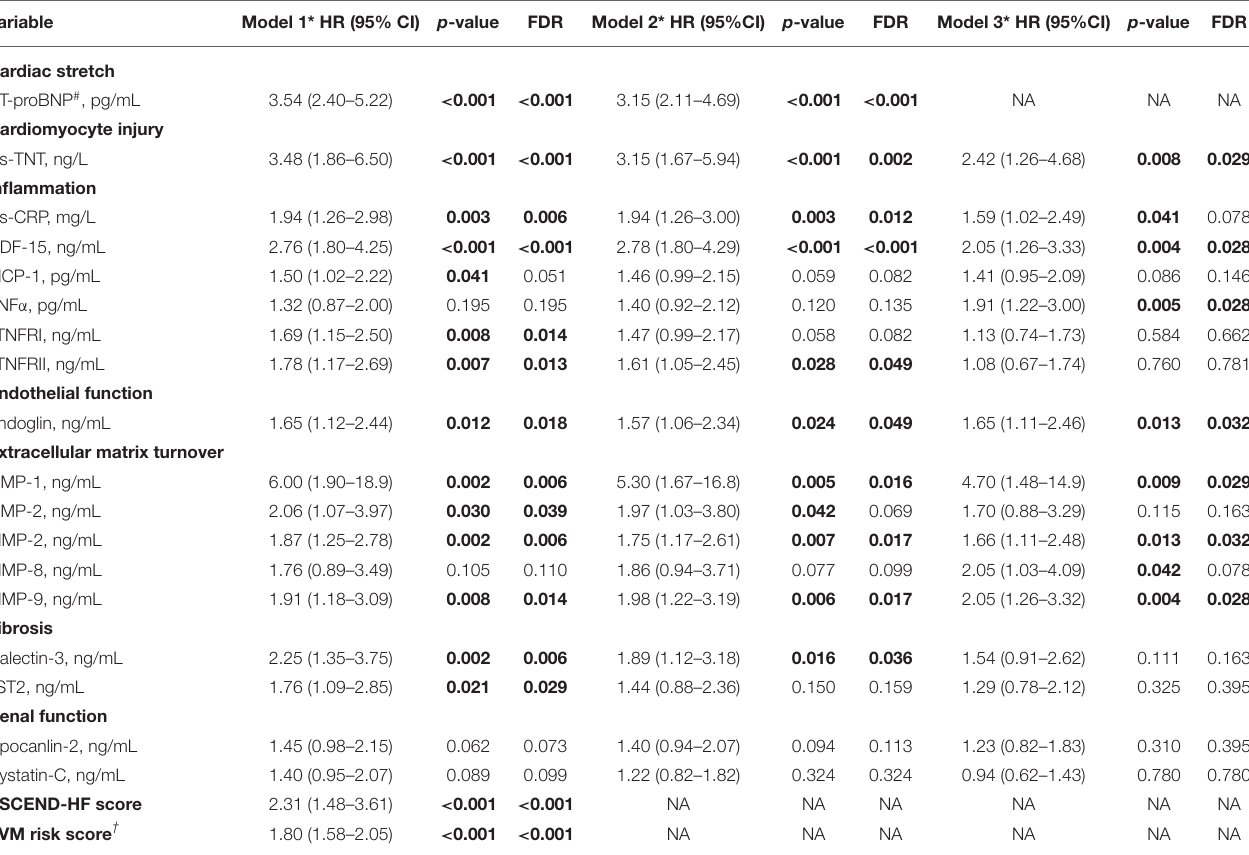
TABLE 3 | Associations between biomarkers and the 2-year risk of all-cause death by univariate and multi-variate analysis.